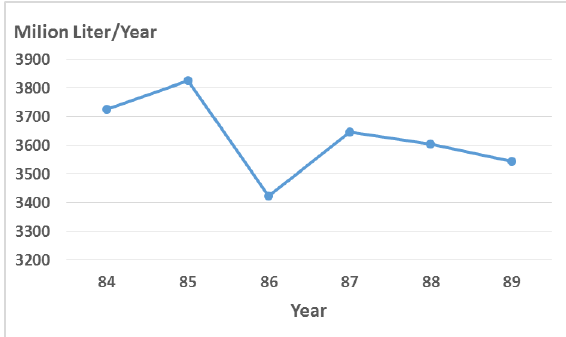
Figure 1. Annual gasoline consumption for city of